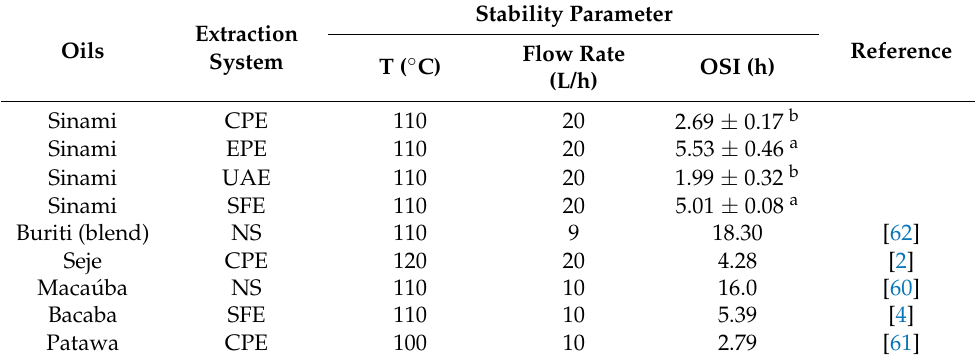
Table 2. Oxidative stability (OSI) of the sinami oils that were obtained using the four extraction systems and other oils from South American palm